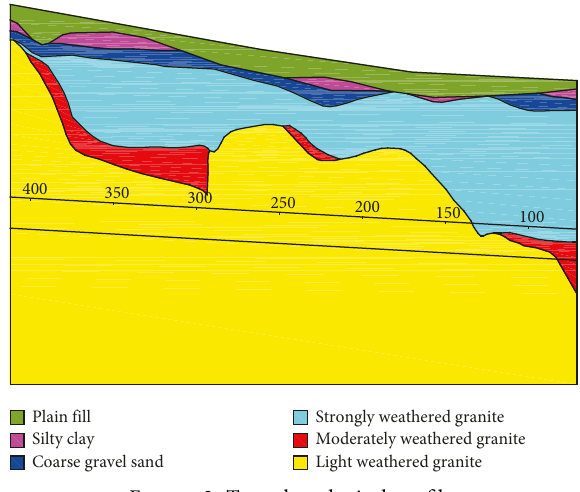
Plain fill Silty clay Figure 2: Tunnel geological